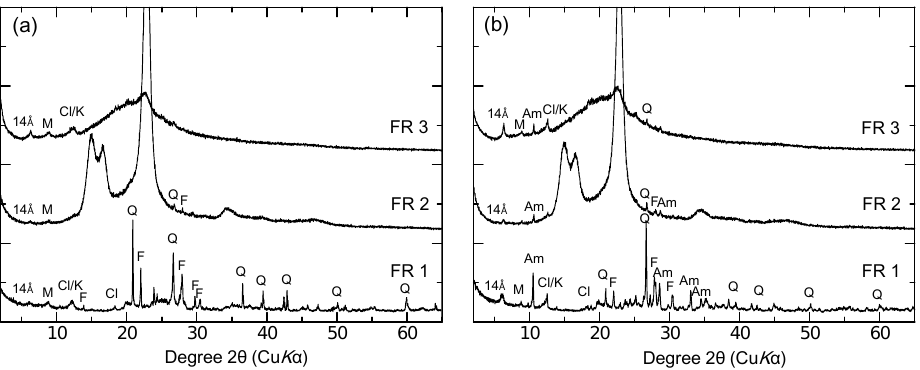
Fig. 5. X-ray diffraction patterns of suspended solids in the Natsui River (a) and Same River (b) after the heavy rain event (Typhoon Roke) in 2011. Legend for abbreviations of minerals: 14 Å – chlorite, vermiculite, smectite; M – mica; Am – amphibole; F – feldspar; Q – quartz; Cl/K – chlorite and/or kaolin.